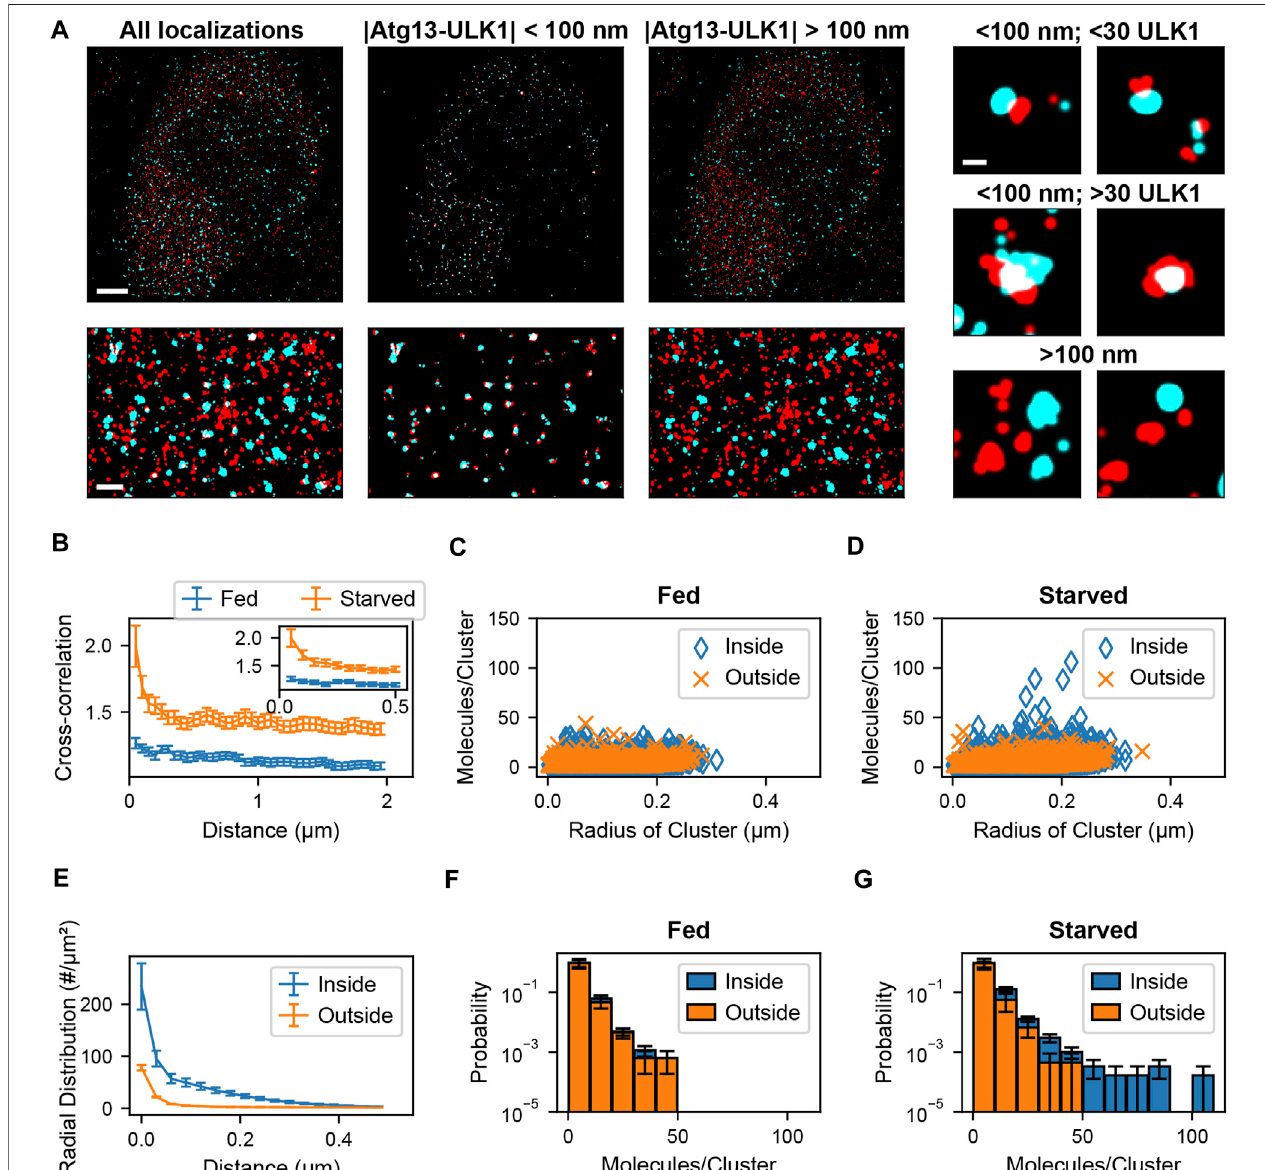
FIGURE 4 | Colocalization analysis of ULK1 and ATG13 via cross correlation. (A) Left shows a two-color overlay of PALM images of mEos2-ULK1 (red) and HaloTag-ATG13boundtoJF646(cyan)withacorrespondingmagni fi edimage(bottomleft)takenfromarepresentativestarvedcell(Scalebartopleft:5 µm;bottomleft: 1 µm). Middle represents the ATG13 localizations that are within 100 nm of ULK1 molecules and considered colocalized with ULK1 clusters. The corresponding magni fi ed image (bottom middle) highlights the increased visibility of colocalized ULK1 clusters after fi ltering out non colocalized molecules using the cross- correlation analysis framework. Right represents ULK1 and ATG13 localizations that are further than 100 nm away from each other and are not considered colocalized. ExamplesofindividualclustersthatareandarenotcolocalizedwithATG13localizationsarealsodisplayed(scalebar:150 nm). (B) Cross-correlationplotbetweenULK1 molecules and ATG13 localizations in fed (blue) and starved (red) cells. The cross correlation plot was calculated by using k dimensional trees to obtain ATG13 localizations within 2 µm of ULK1 molecules across the entire fi eld of view. The inset graph represents the onset of leveling of the cross correlation plot around 100 nm. The error bar corresponds to SEM from fi ve fed and fi ve starved cells. (C,D) show the quanti fi cation of the number of molecules and radii of ULK1 clusters colocalized with ATG13 (inside, blue) and not colocalized with ATG13 (outside, orange) in fed (C) and starved (D) cells. ULK1 localizations that are and are not colocalized with ATG13 exhibited similar distributions in fed cells while ULK1 localizations that colocalized with ATG13 in starved cells formed structures that contained more molecules and wereinterpreted tobe forming autophagosomes. (E) The radialdistribution function further quanti fi esthe localdensity difference between ULK1colocalized (inside, blue) vs. non ATG13 colocalized (outside, red) ULK1 molecules in starved cells. The error bar represents SEM from fi ve starved cells. Figure (F) and (G) display a normalizedhistogramofthenumber ofULK1moleculesinaclustercolocalizedwithATG13(inside, blue)andnotcolocalizedwithATG13(outside, orange)infed (F) and starved (G) cells. The error bar corresponds to SEM from fi ve fed and fi ve starved cells. While there was no noticeable difference in ATG13 colocalized and non ATG13 colocalized distributions in fed cells, there was a signi fi cant difference in both distributions in starved cells where ATG13 colocalized clusters contained the highest number of ULK1